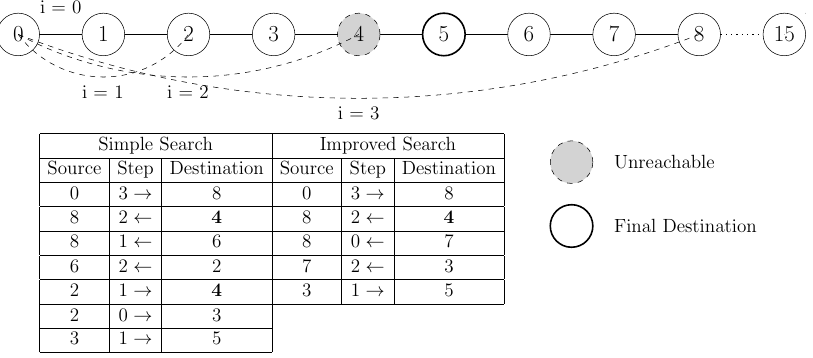
Figure 2. Example of binary horizontal search with node